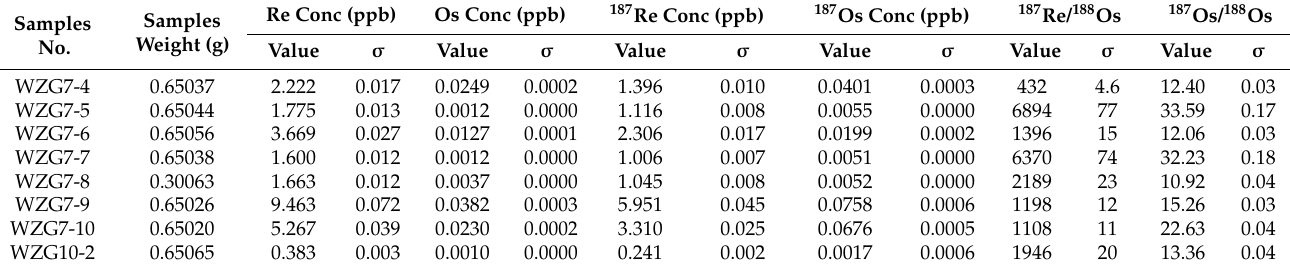
Table 1. Re-Os compositions of pyrite from the Weizigou